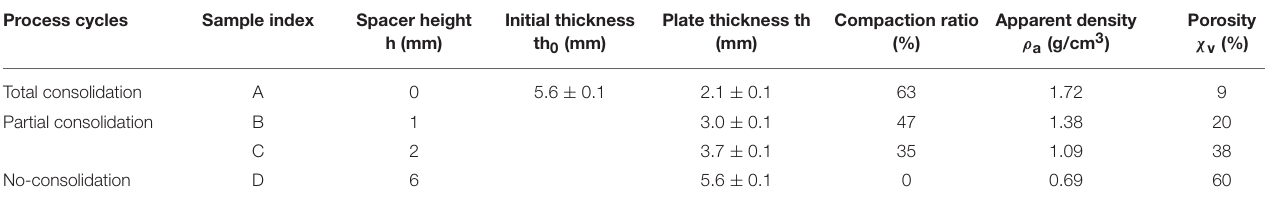
TABLE 2 | Compaction ratios and porosity volume fraction of the thermoplastic composite plates manufactured by different process cycles. Process cycles